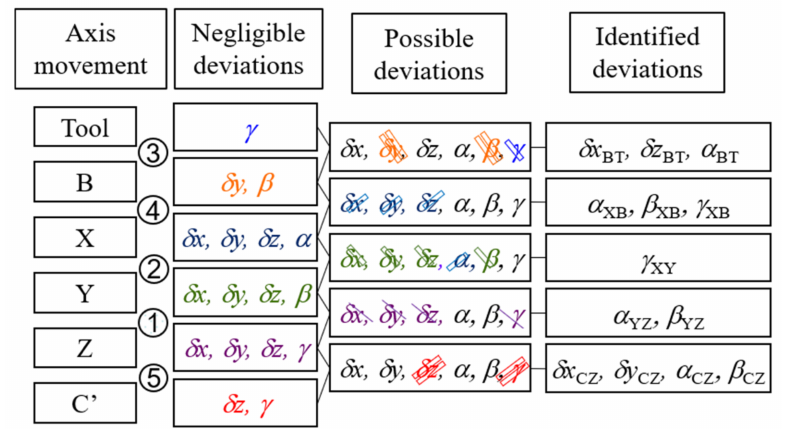
Figure 2. Definition of geometric deviations according to the considered multi-tasking machine